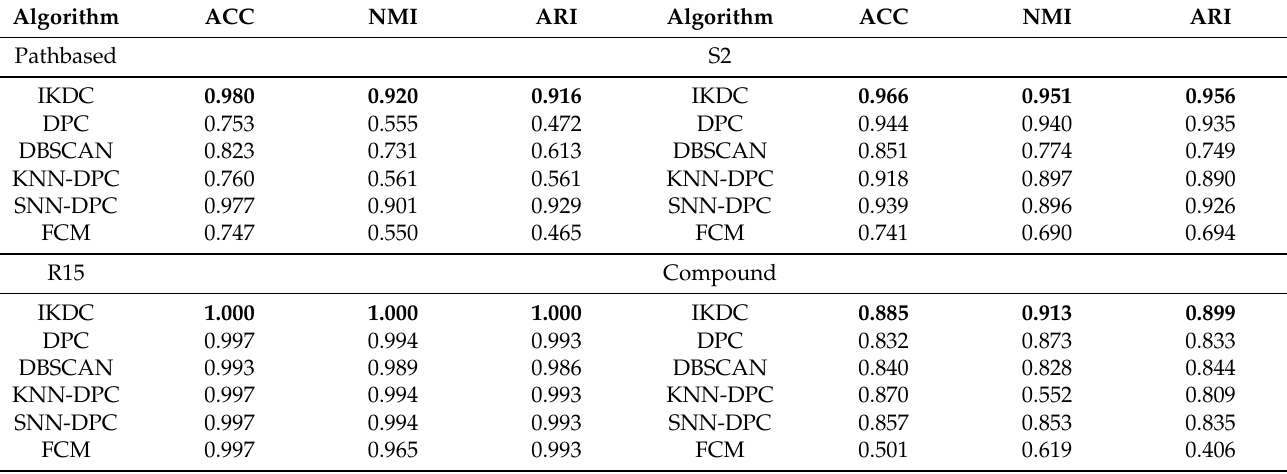
Table 5. ACC, NMI, and ARI of six algorithms on different synthetic